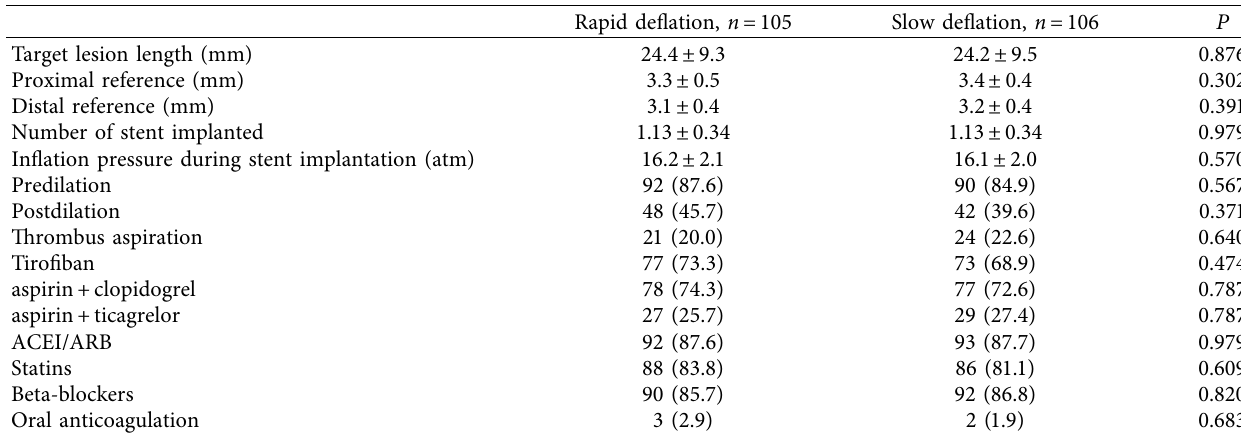
Table 3: PCI characteristics and